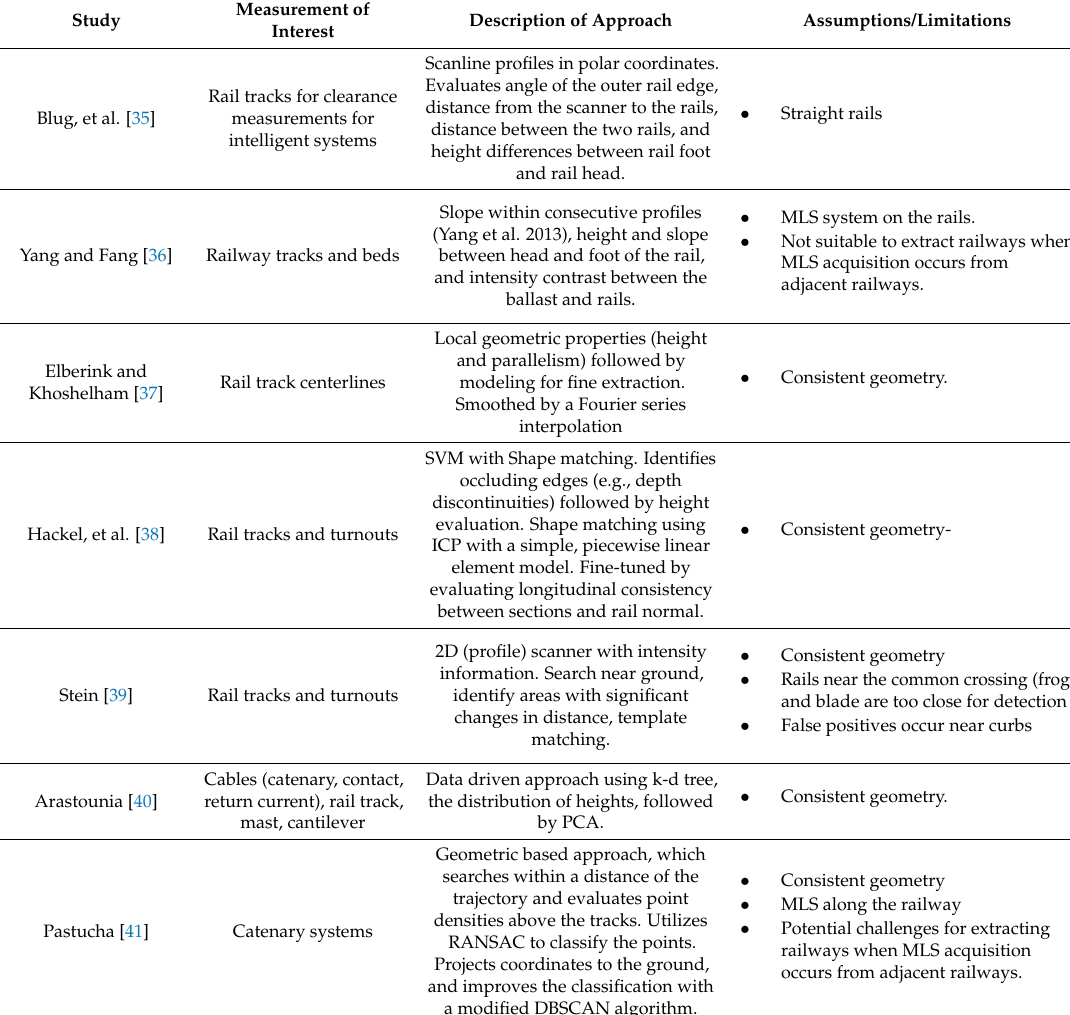
Table 1. Descriptions of object extraction techniques for